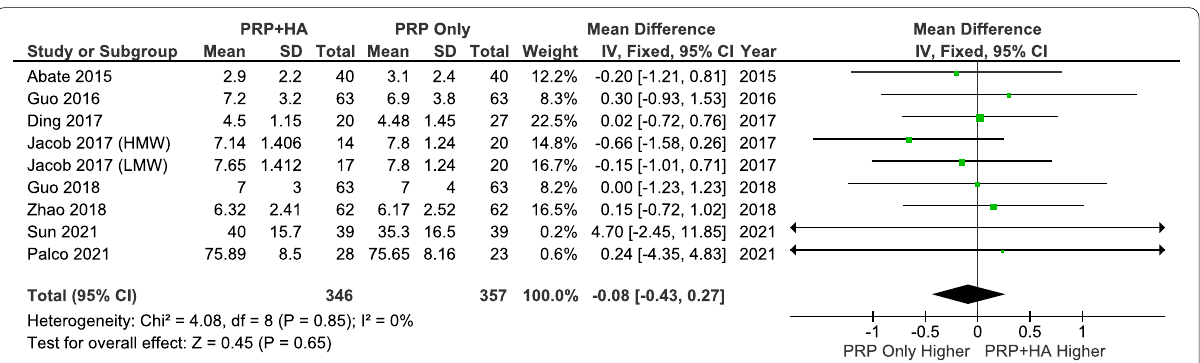
Fig. 4 Showing the Forest plot comparing the VAS scores between PRP